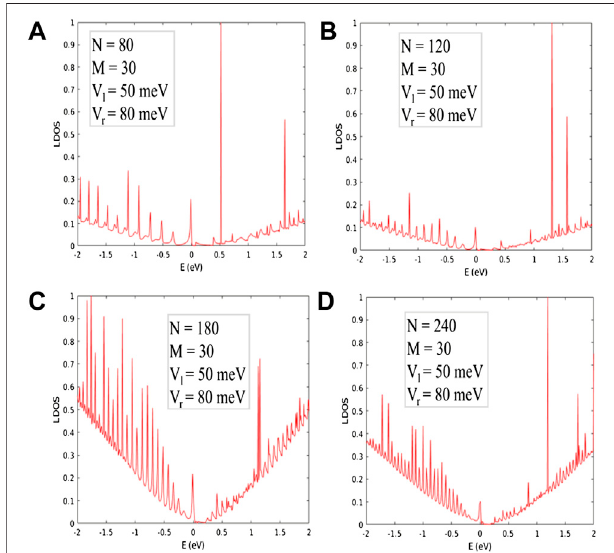
FIGURE 5 | LDOS for symmetric potential well with (A) N = 80, (B) N = 120, (C) N = 180, and (D) N = 240.